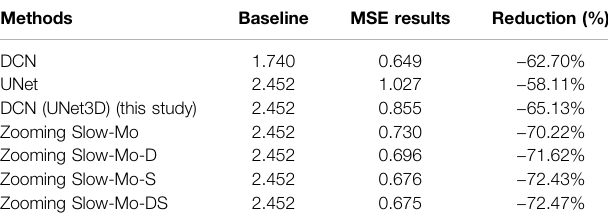
TABLE 3 | Performance comparison with